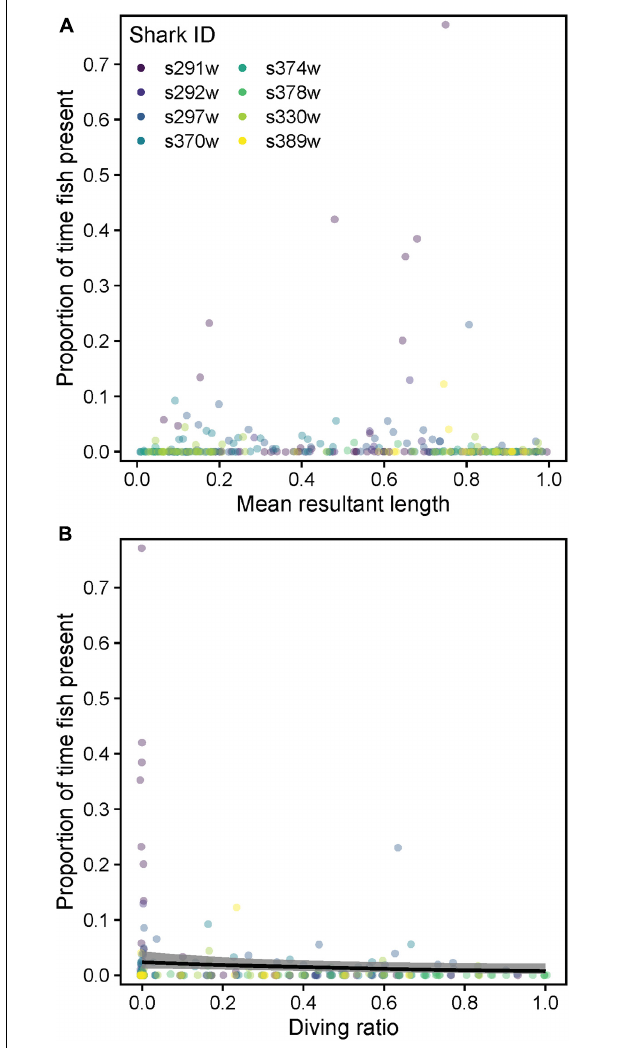
FIGURE 11 | Relationships between the proportion of time with fish visible in video footage (p fish ) and (A) mean resultant length and (B) diving ratio. Variables were computed over 15 min windowed intervals for each shark. Predicted relationships (gray shading = 95% confidence intervals) from a zero-inflated beta mixed model are shown where a significant effect was detected ( p <